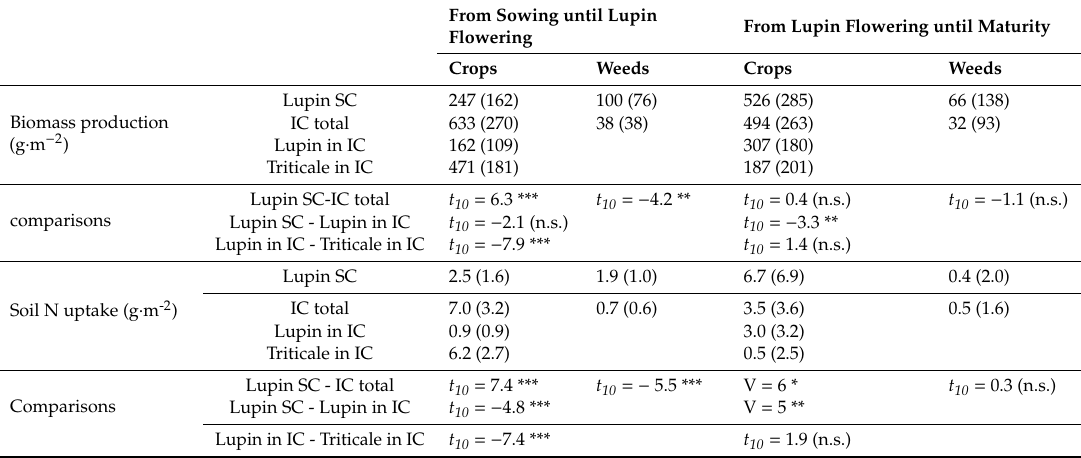
Table 4. Crop and weed biomass production and soil N acquisition at the 11 sites in lupin sole crops (SCs) and lupin–triticale intercrops (ICs) during two periods, from sowing to lupin flowering, and from lupin flowering to maturity. From Sowing until Lupin